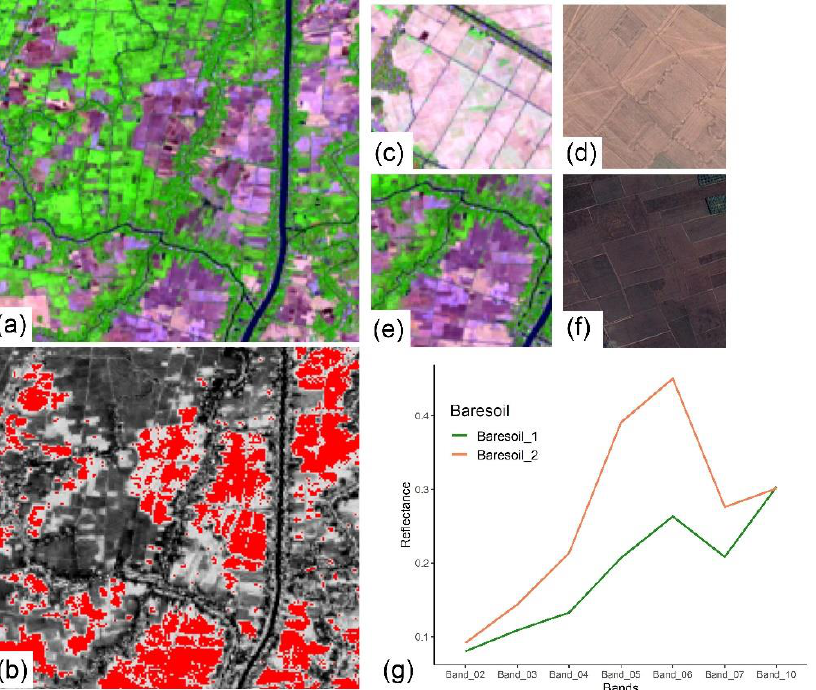
Figure 9. ( a ) False-color composite (RGB: 6-5-3) at a mixed bare soil area, ( b ) bare soil classified by the MBI thresholding (red), the remnant bare soil areas are in a bright tone, ( c ) a fragment of typical dry bare soil (type #2) can be detected by MBI on Landsat 8 image, ( d ) dry bare soil on Google Earth image, ( e ) a typical moist bare soil (type #1) is undetectable by MBI on Landsat 8 image, ( f ) wet bare soil on Google Earth image with darker brown tone compared to dry bare soil, and ( g ) spectral profiles of dry and wet bare soil.